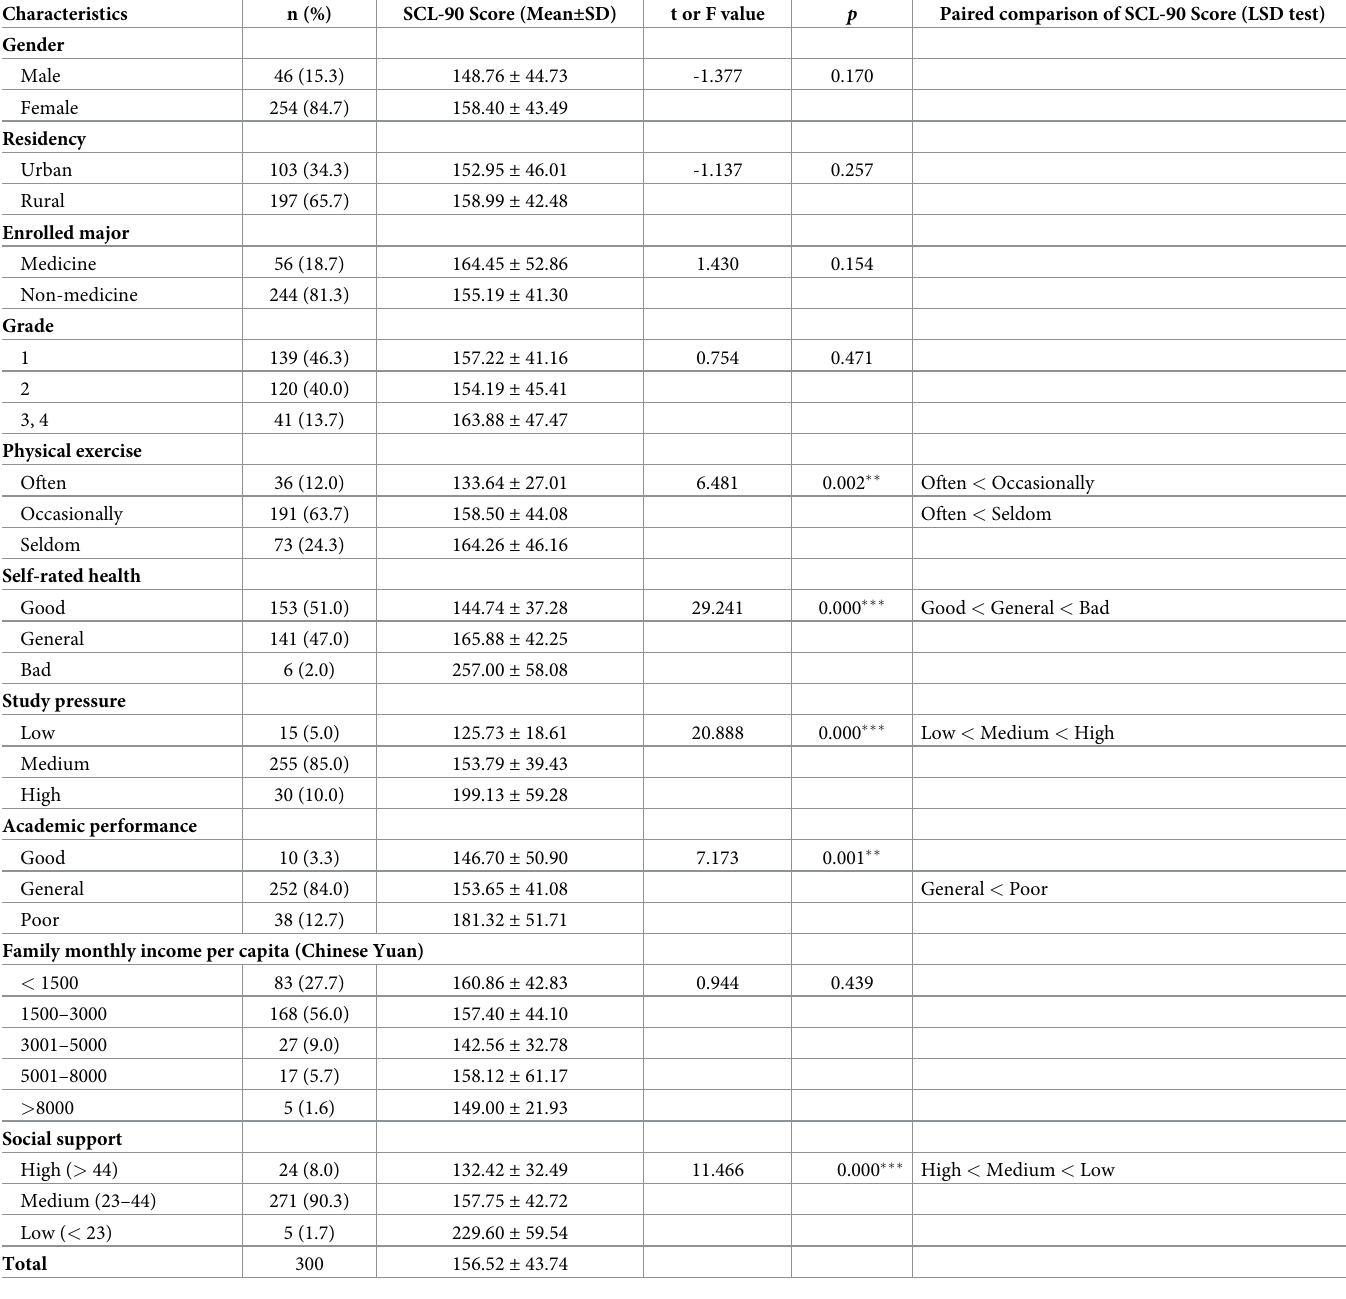
Table 1. SCL-90 total scores of respondents by sociodemographic characteristics.